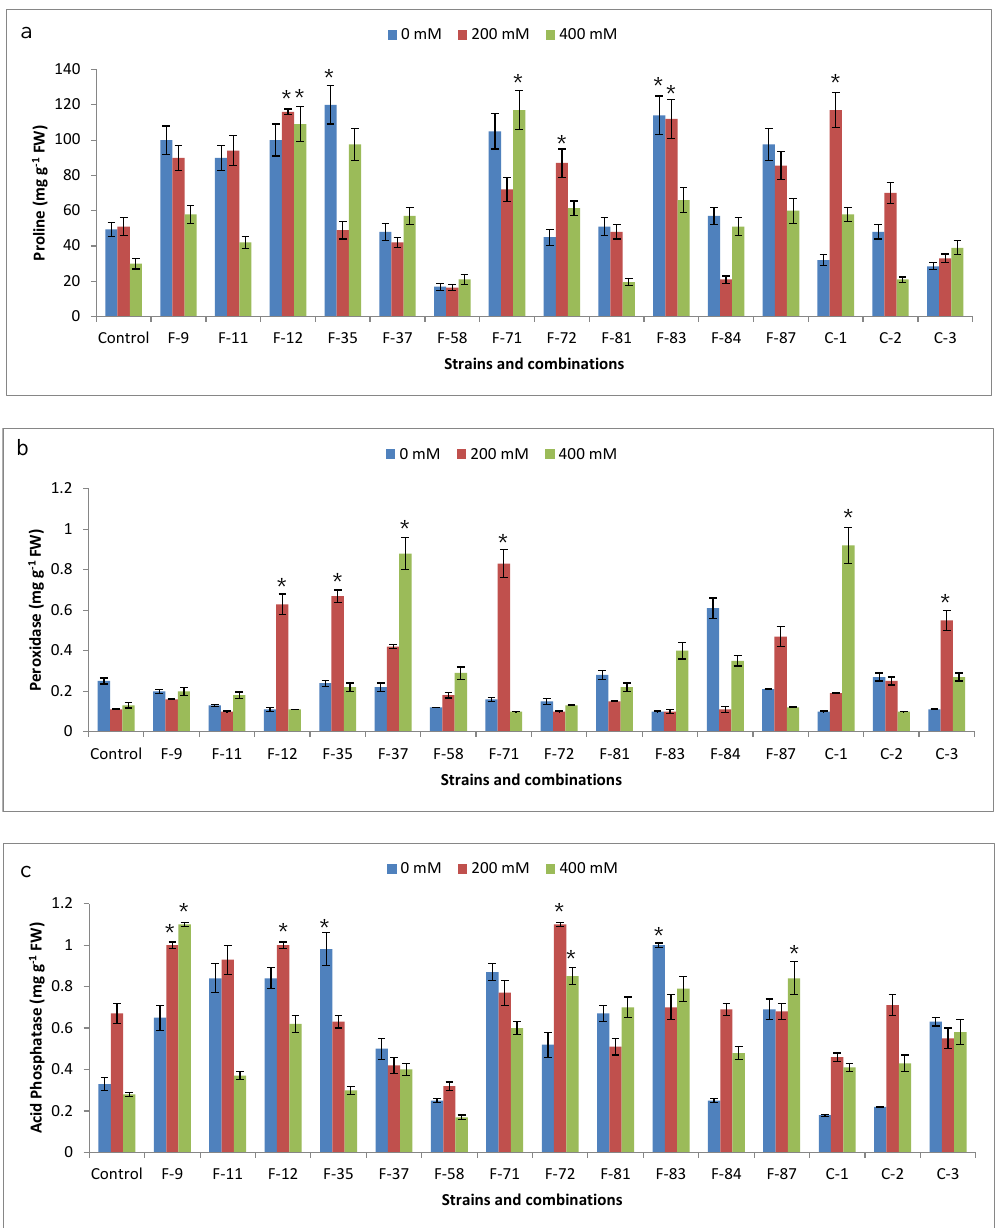
Figure 5. Effect of single and mixed bacterial inoculations and different salinity levels on the activities of antioxidant metabolites or enzymes: ( a ) Proline; ( b ) Peroxidase; ( c ) Acid phosphatase. Bars represent mean ± SE of three replicates. Treatments followed by * indicate significant difference over respective control using Duncan’s multiple range test ( p ≤ 0.05).